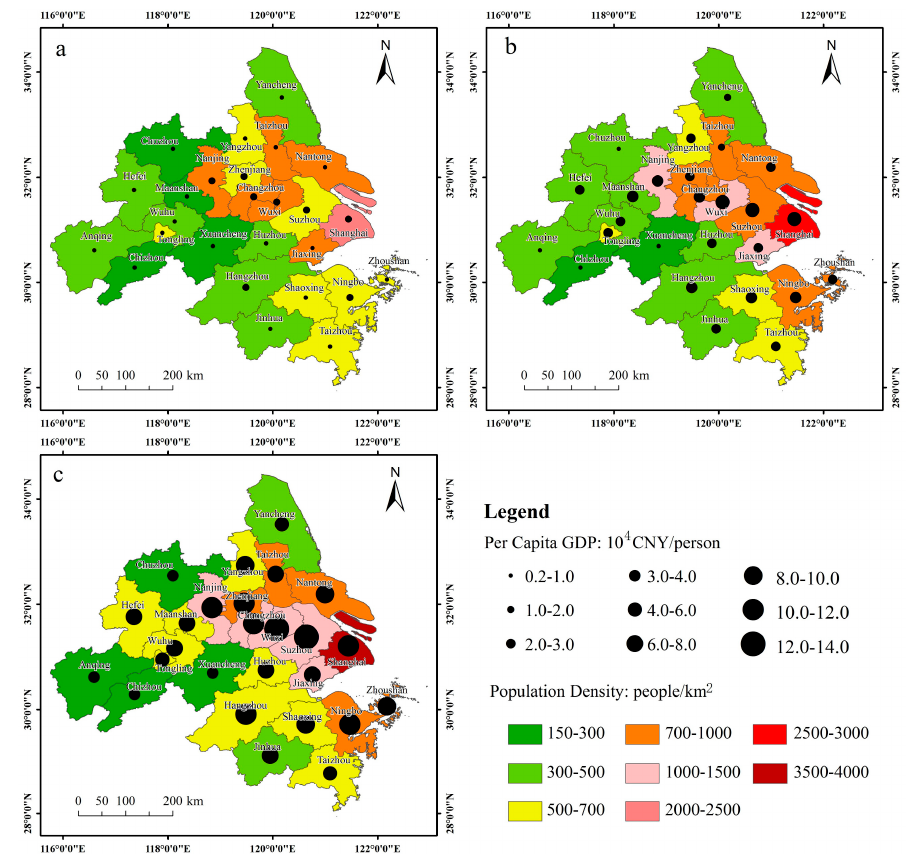
Figure 2. Population density and per capita gross domestic product (GDP) grading for the 26 YRDUA cities in 1995 ( a ), 2005 ( b ), and 2015 ( c ). The population here refers to the resident population.